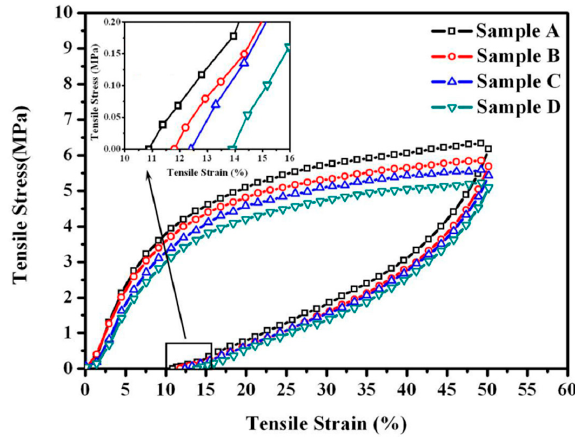
Figure 3. Tension-recovery stress-strain curves of EPDM/PP (60/40) TPV samples taken at different DV times.